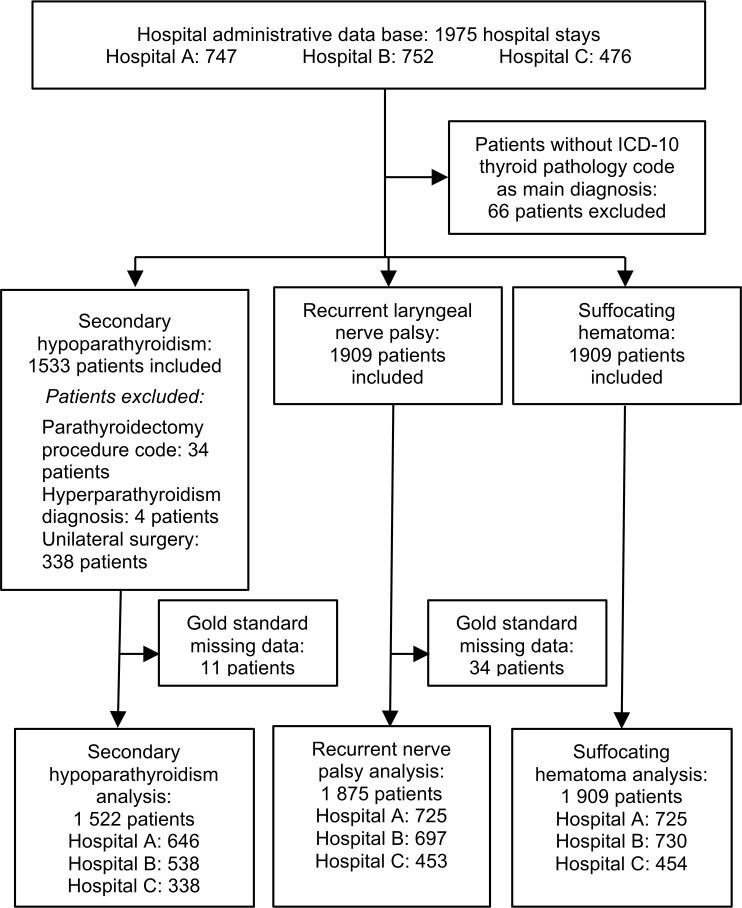
Study flowchart.